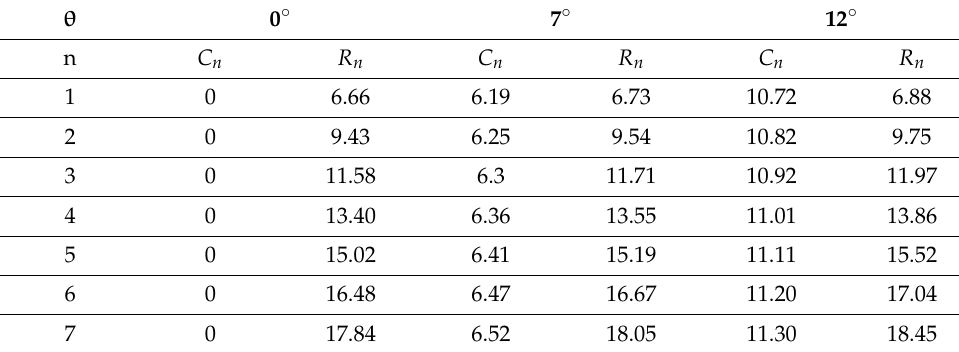
Table 1. Geometric parameters of the calculated FZPs in different